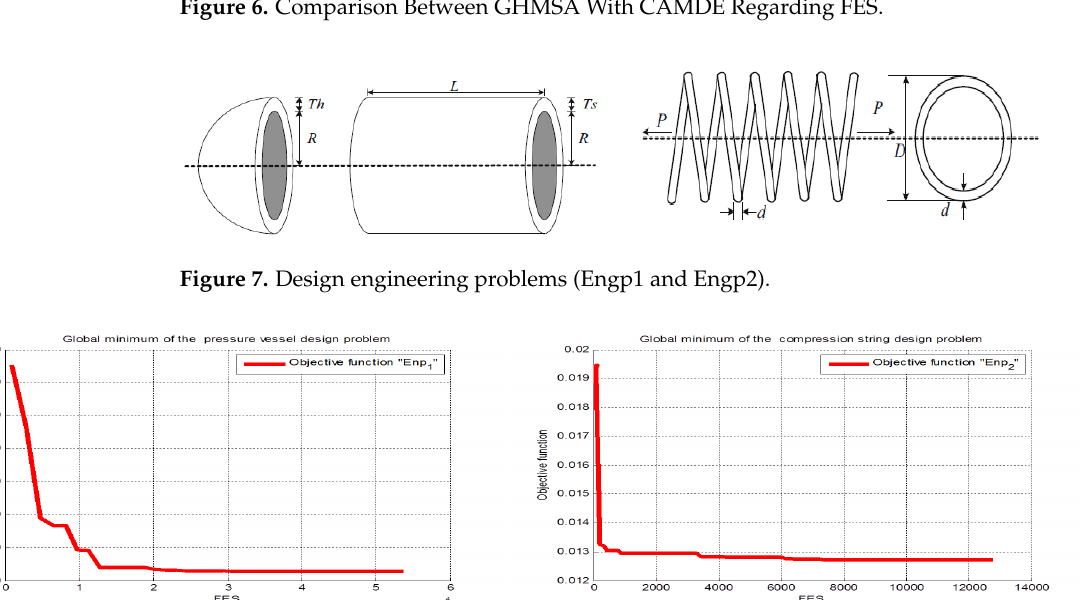
Figure 6. Comparison Between GHMSA With CAMDE Regarding FES.